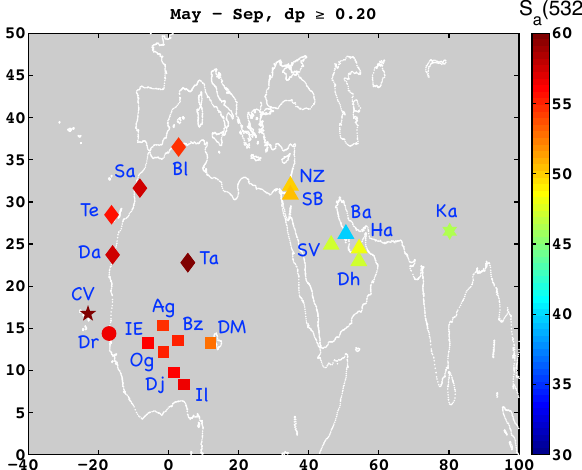
Fig. 12. Median lidar ratios for all available AERONET retrievals with depolarization ratios greater than 0.2 during the months May– September.